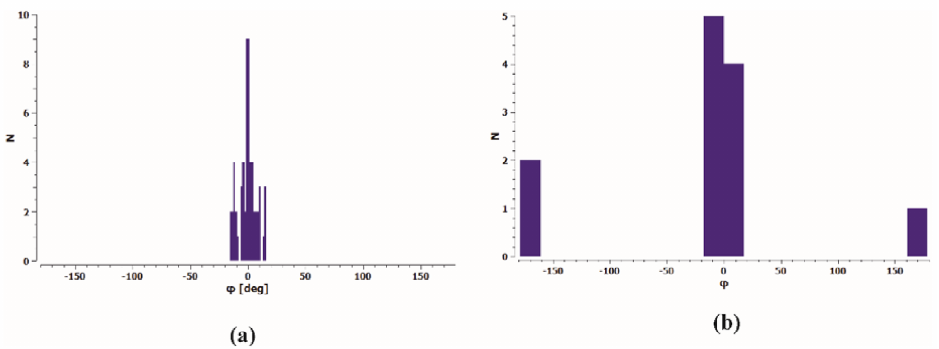
Figure 2. Histogram of torsion angle ϕ = N1–C2–N4–N5 in thiosemicarbazide system for ( a ) organic molecules and ( b ) ligands in Cu complexes deposited in CSD.